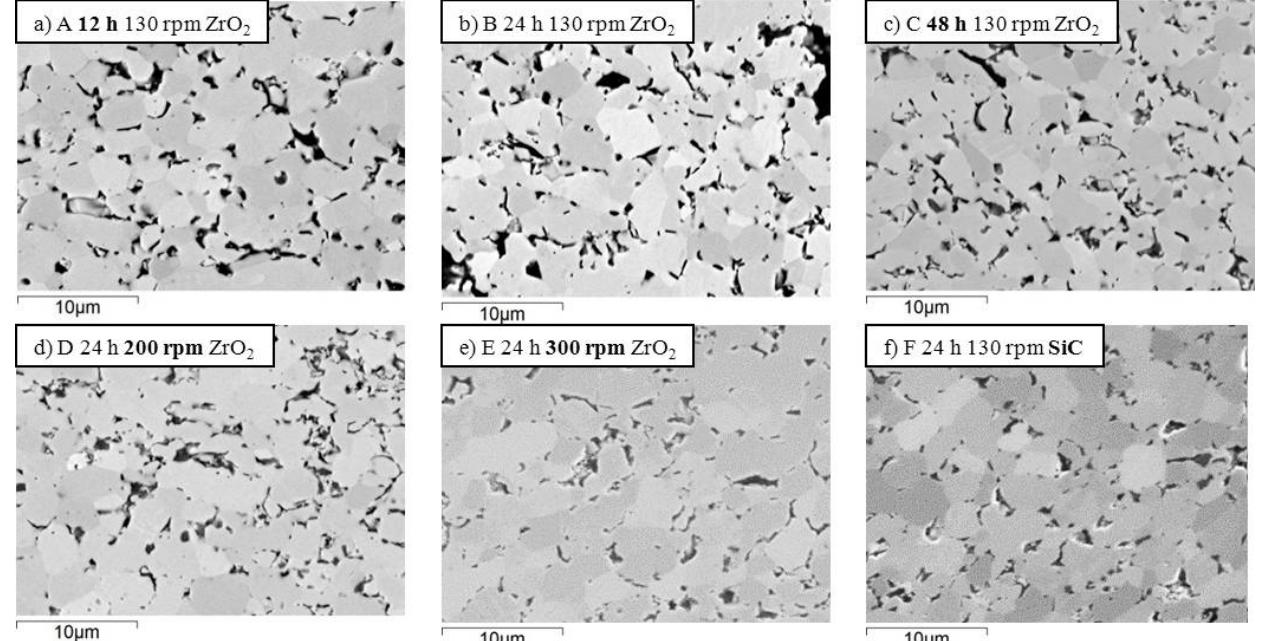
Figure 1. SEM-images of the polished sections of samples: ZrB correspond to secondary phases (amorphous Si-O-N, ZrN and